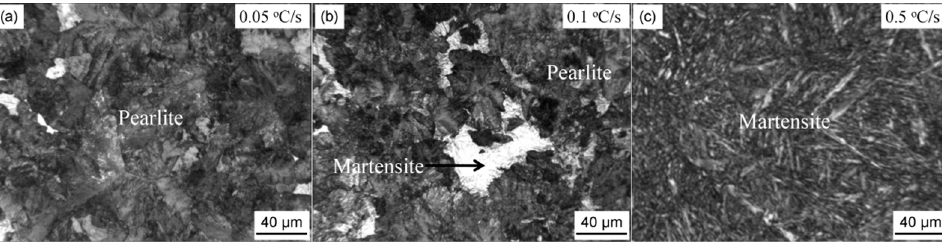
Figure 2. Optical micrographs of Alloy 2 at the cooling rates of ( a ) 0.05 °C/s, ( b ) 0.1 °C/s, and ( c ) 0.5 °C/s.